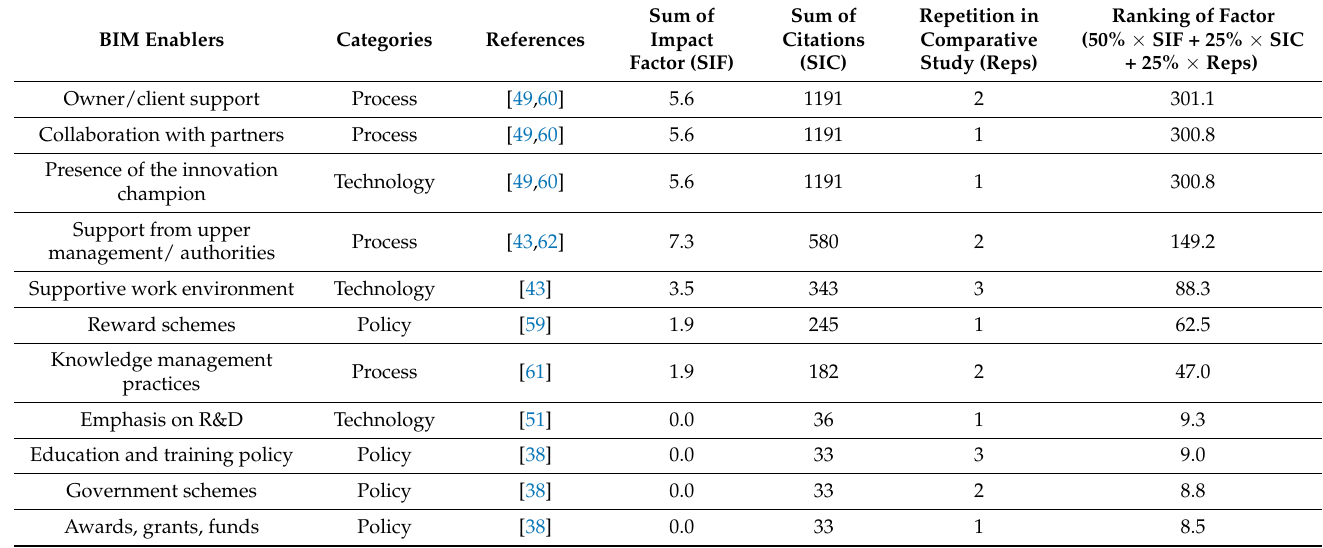
Table 10. Scores and ranks of BIM innovation enablers in developing countries.